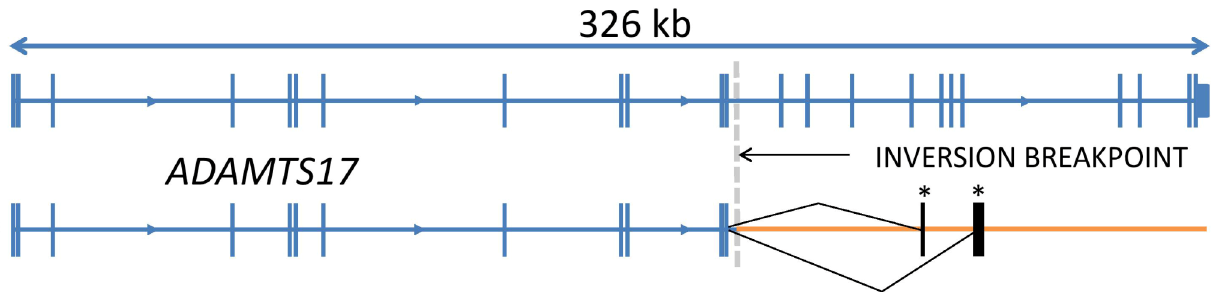
Fig 6. Schematic gene arrangements for the reference and inversion alleles. Transcript arrangements for the ADAMTS17 reference gene and ADAMTS17 after the inversion event. Novel exons are marked with an asterisk.